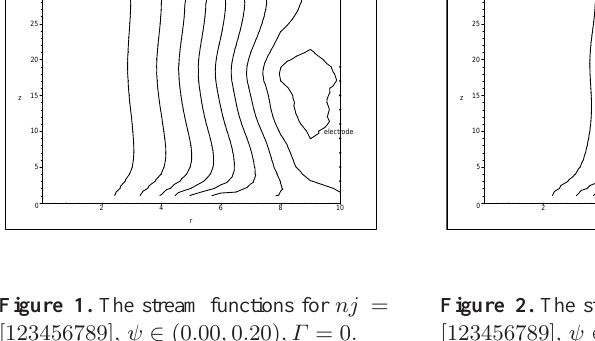
Figure 1. The stream functions for nj = [123456789] , ψ ∈ (0 . 00 , 0 . 20) , Γ = 0 .